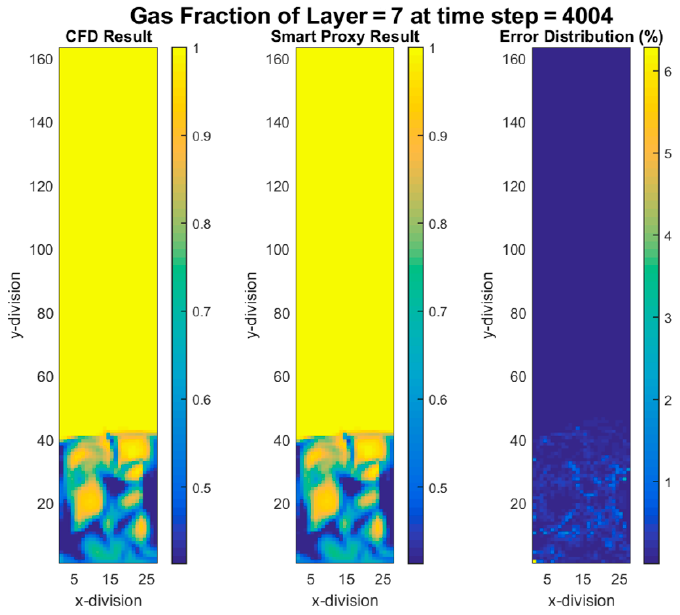
Figure 18. CFD and cascading smart proxy results for gas volume fraction at K = 7 cross-sectional plane and time-step = 4004.